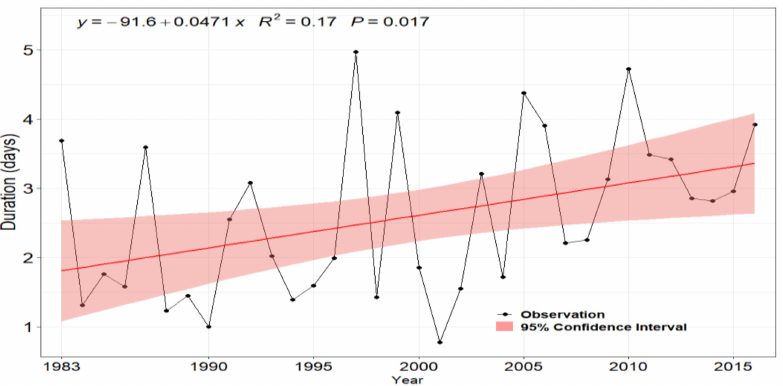
Figure 3. Duration of heatwave events that occurred in the observation period (1983–2016) over Tanzania.